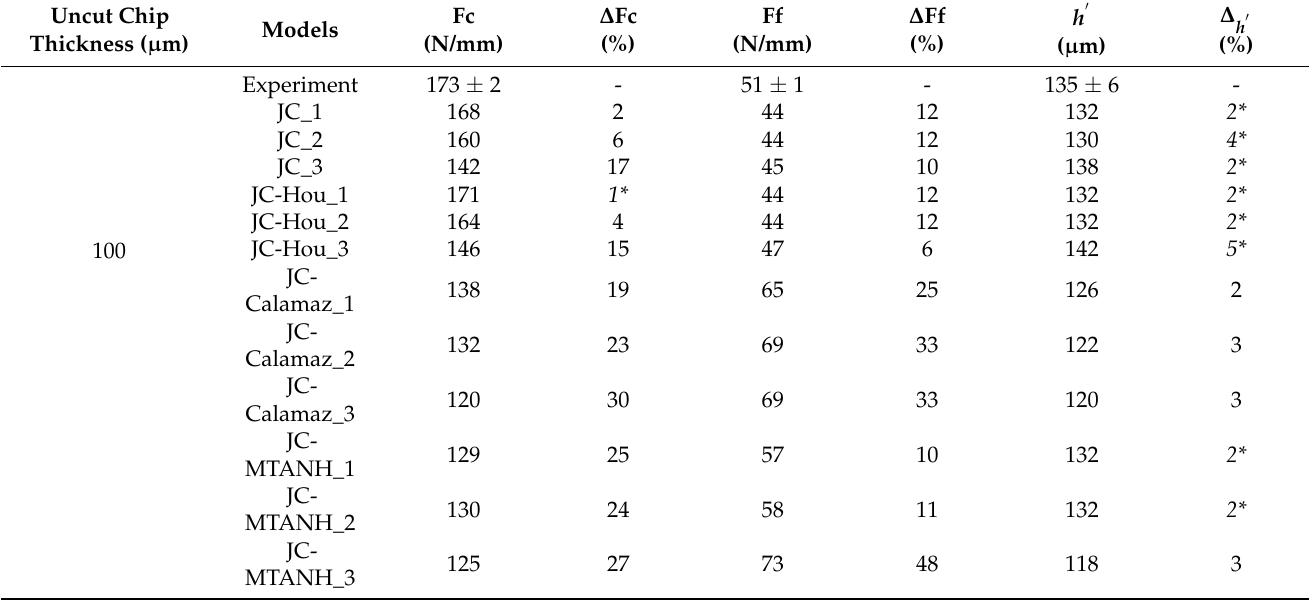
Table 9. RMS cutting force (Fc), feed force (Ff), chip thickness ( h (cid:48) ) and ∆ x differences with the experimental forces of h = 100 µ m. Uncut Chip Thickness ( µ